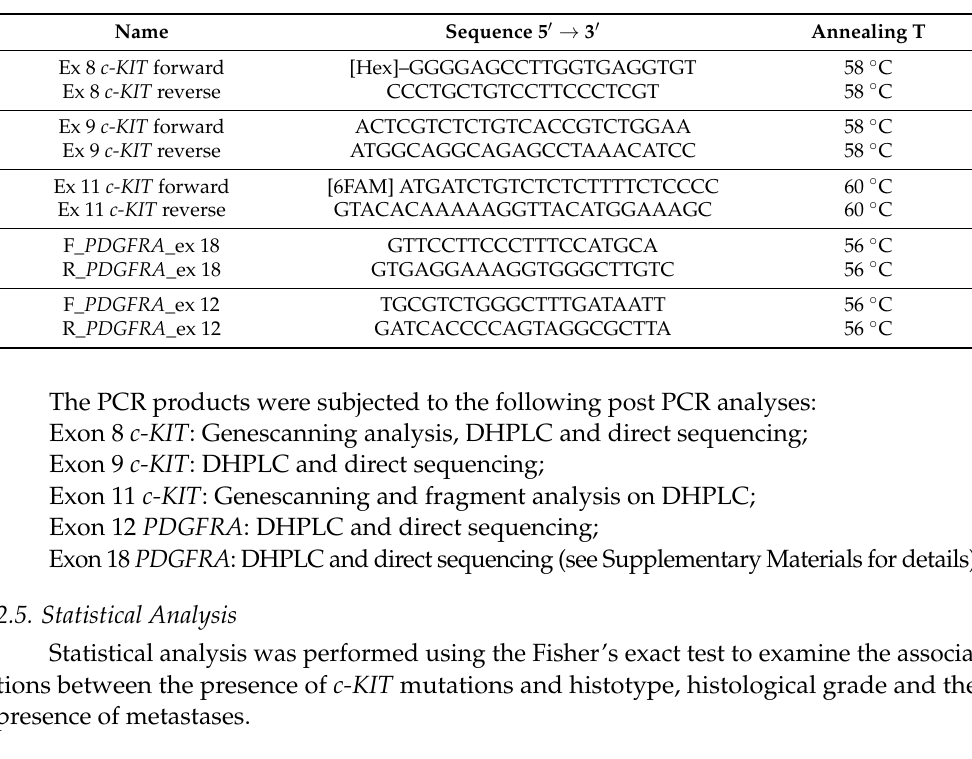
Table 1. Primers and their respective annealing temperature used in the study.